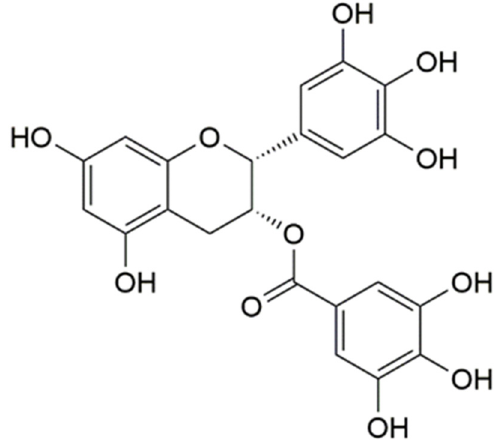
Figure 1. Structure of epigallocatechin-3-gallate.